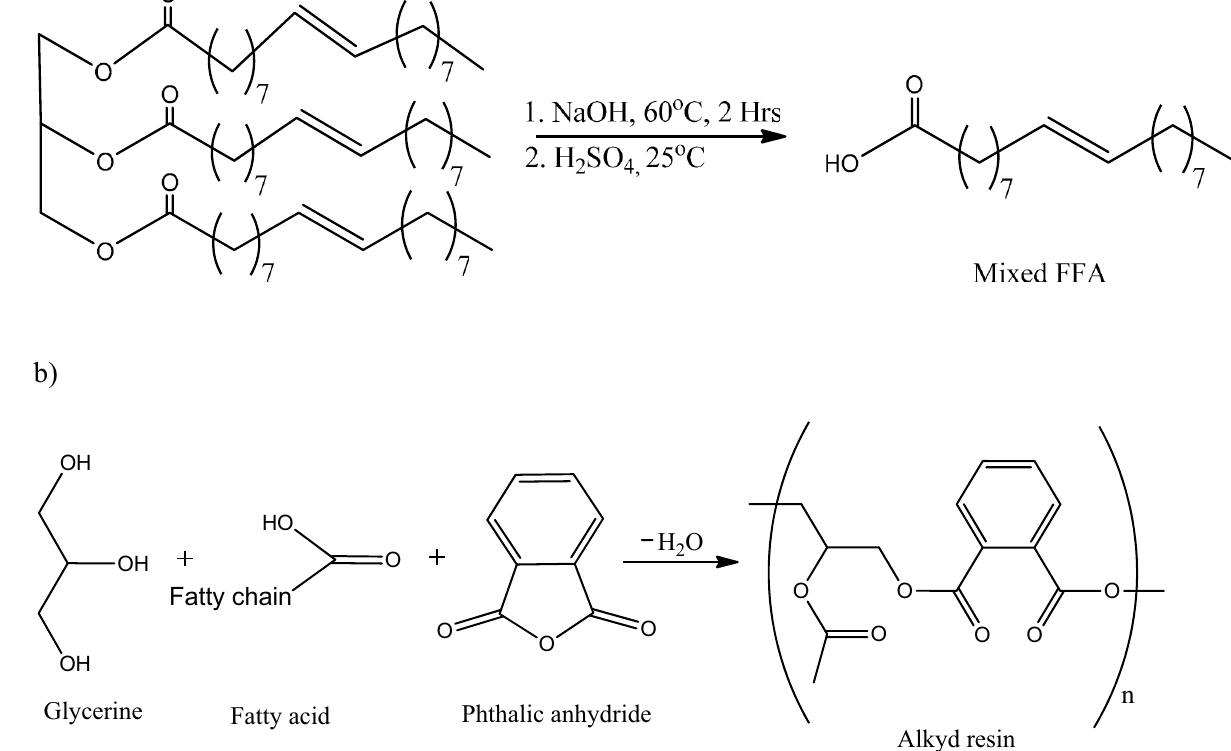
Figure 1. ( a ) Extraction of FFA by saponification and acidification of crude castor oil. ( b ) General reaction for fatty acid alkyd resin.